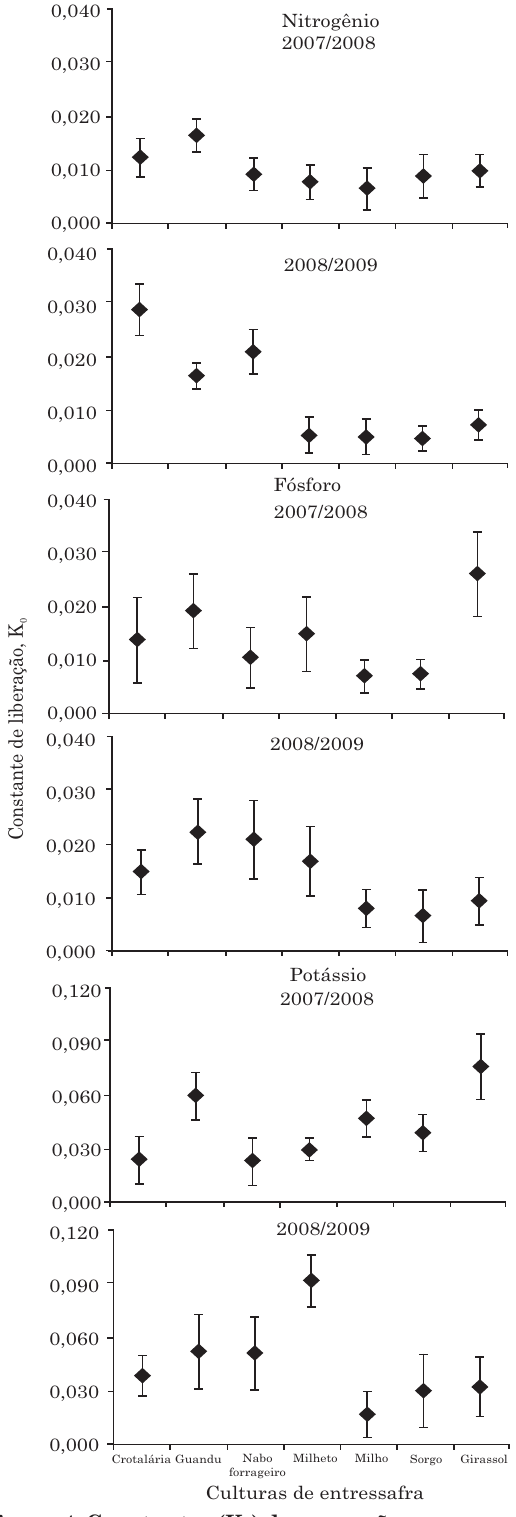
Figura 4. Constantes (K 0 ) das equações exponenciais simples ajustadas (y = A 0 .e -K0.t ) para a liberação de nitrogênio, fósforo e potássio dos resíduos das culturas de entressafra. As barras verticais representam o intervalo de confiança do parâmetro K 0 a 5